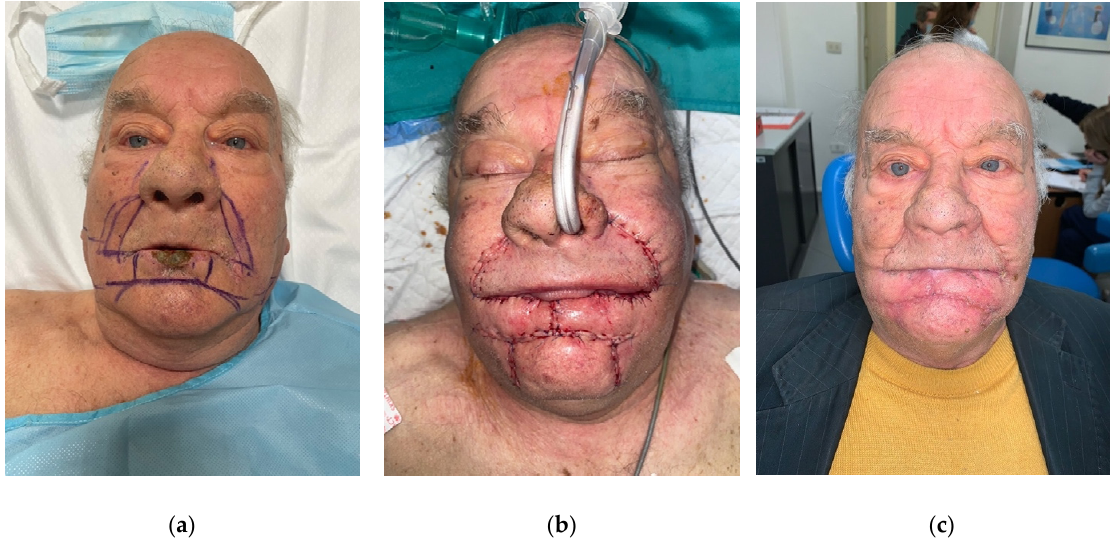
Figure 2. ( a ) Carcinoma of lower lip mucosa involving the skin (stage IV), ( b ) closure of the surgical defect with a double Bernard/Fusama flap, ( c ) photograph of the patient 4 weeks after surgery.